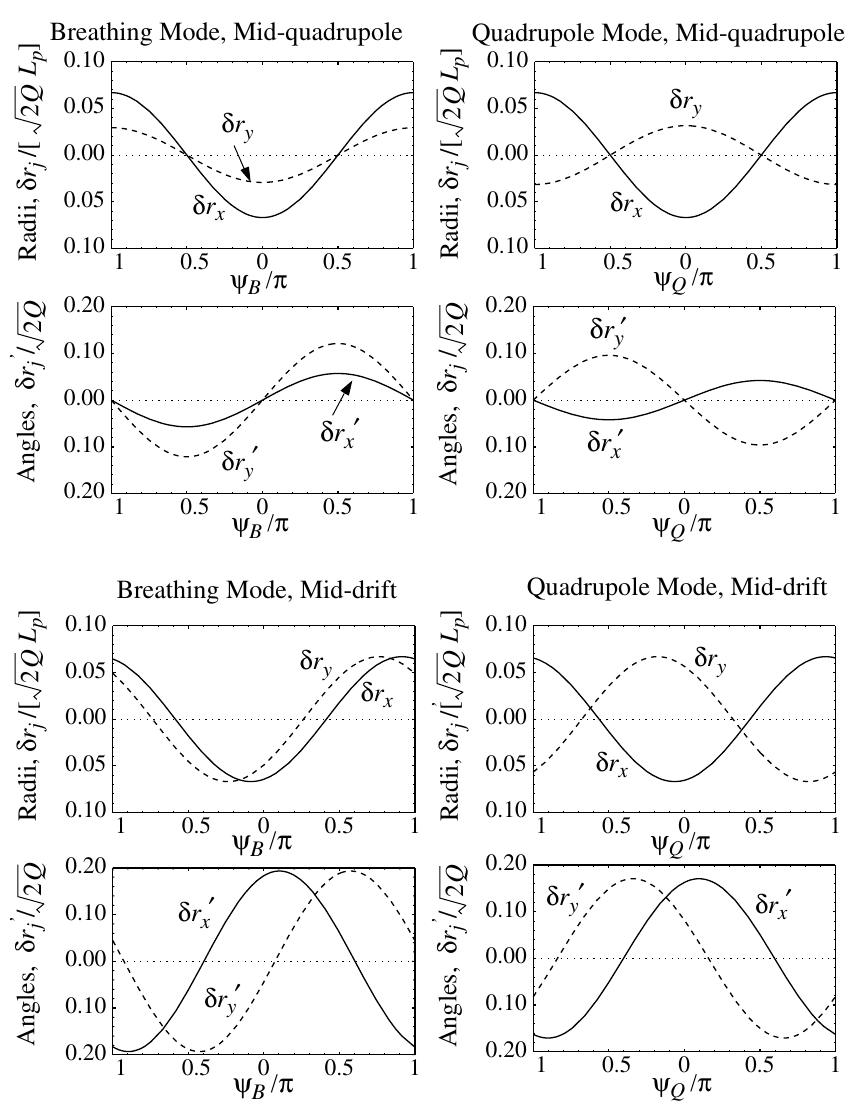
p p (cid:4) and %r 0 = (cid:3) (cid:1)(cid:1)(cid:1)(cid:1)(cid:1)(cid:1)(cid:1) 2 Q L = (cid:1)(cid:1)(cid:1)(cid:1)(cid:1)(cid:1)(cid:1) 2 Q ( j (cid:1) x , y ) plotted versus mode phase j p j (cid:1) 80 (cid:31) , and (cid:24)=(cid:24) (cid:1) 0 : 2 0 0